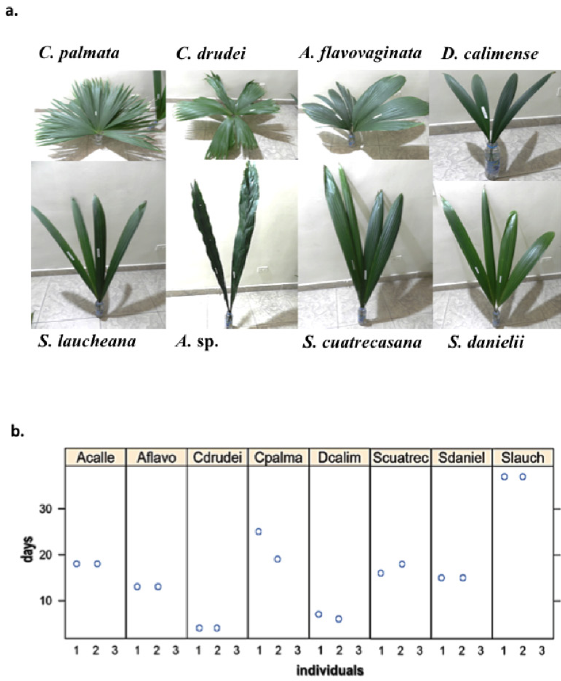
Figure 1 - Durability test (vase life) of eight species of Cyclanthaceae during 37 days. a. State of the leaves on the 16 th day of monitoring. b. Duration times for each